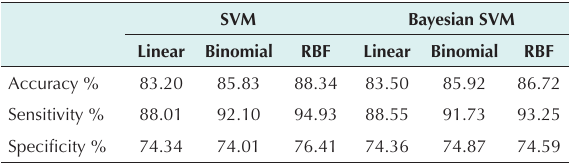
Table 1 . Classification Results by an Average of 800 Runs Using Two Classifiers With Three Kernels